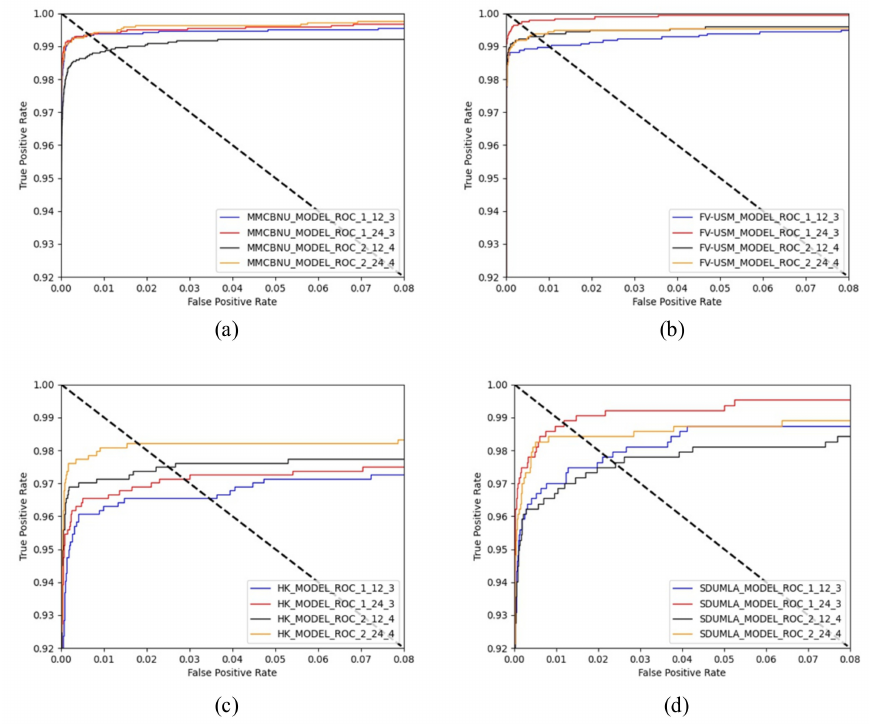
Figure 7. ROC curves of the ViT-Cap model on four public finger vein datasets:( a ) MMCBNU ( b ) FV-USM ( c ) HKPU ( d )